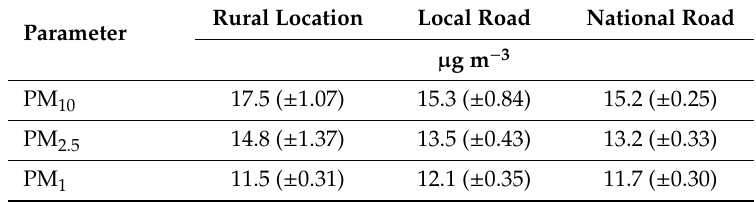
Table 3. Concentrations of PM 10 , PM 2.5 and PM 1 in the apple orchards. Data are means ± SE, n = 15.